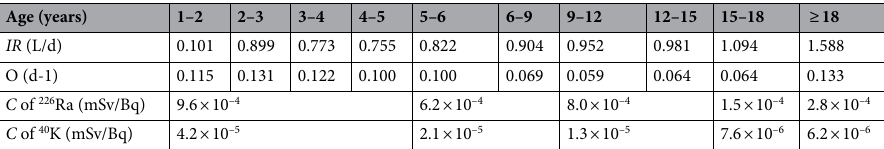
Table 2. The age-adjusted drinking water ingestion rates, outdoor occupancy factors and effective dose conversion